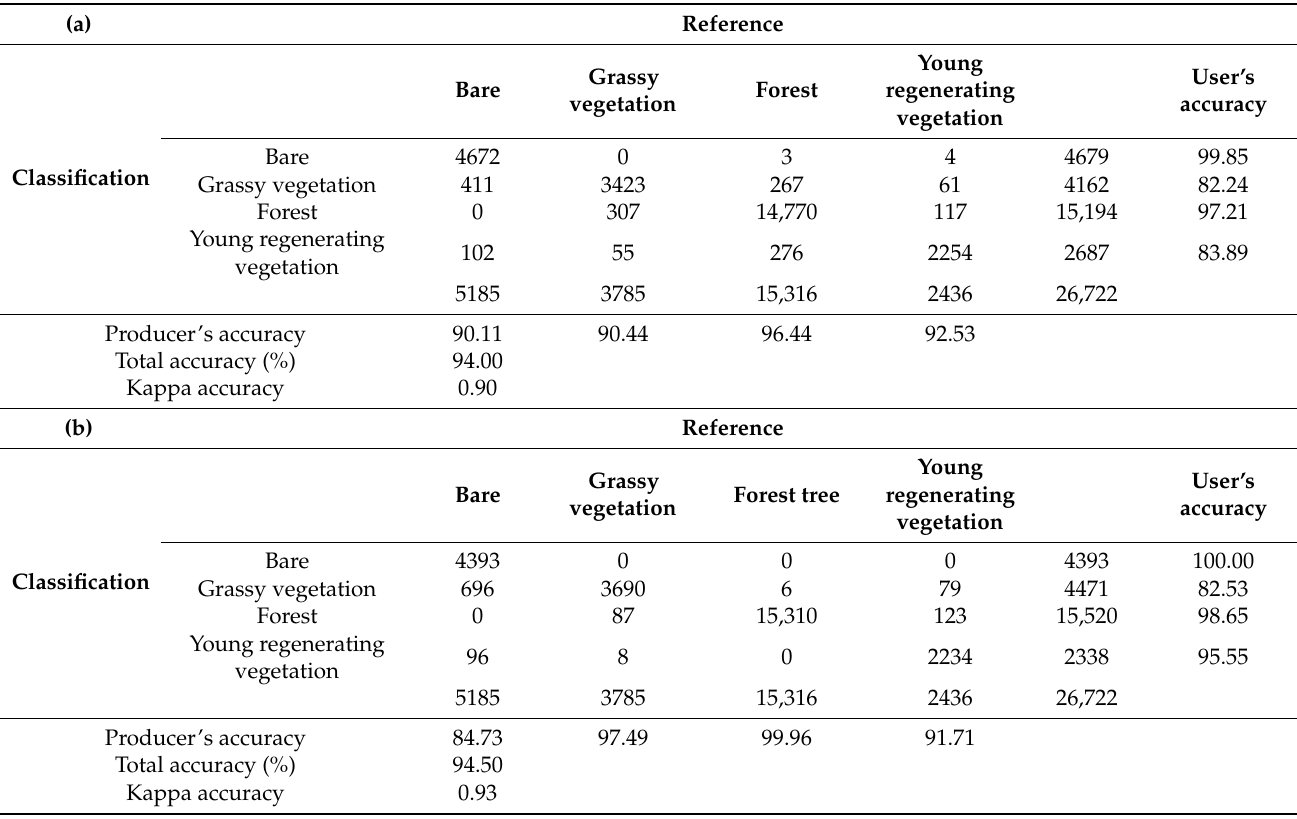
Table 1. Accuracy matrix for ( a ) pixel-based classification and ( b ) object-based